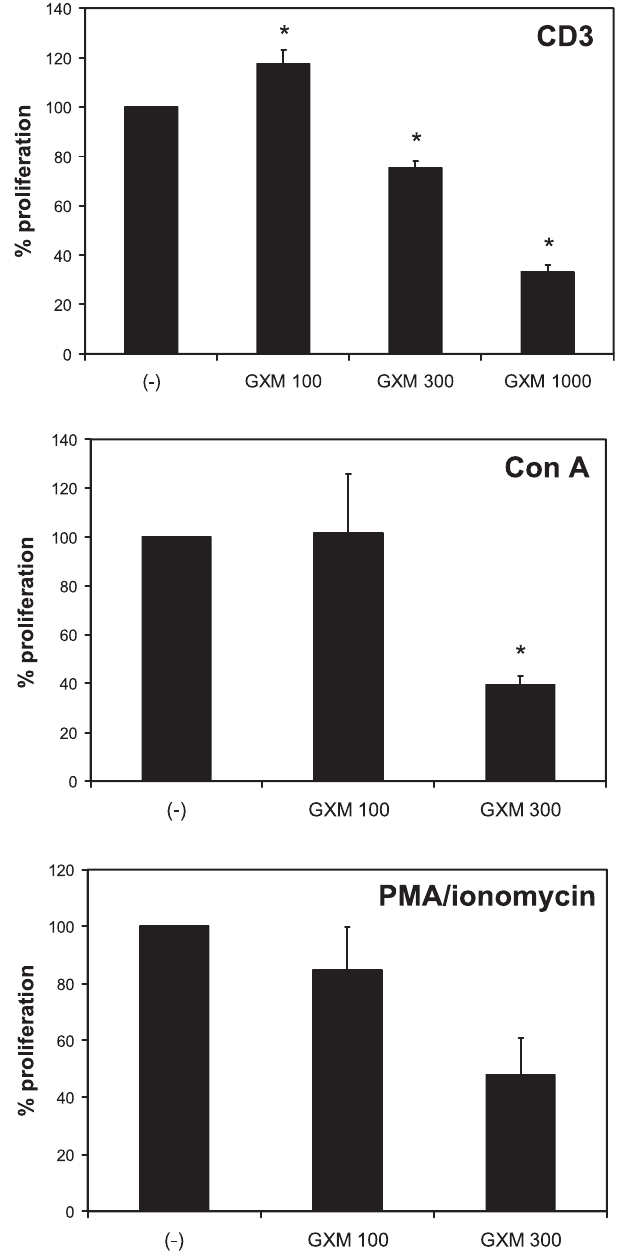
Figure 4. Effect of GXM on T-Cell Proliferation Induced by Anti-CD3, Con A, or PMA/Ionomycin Purified CD4 þ murine T cells were activated with plate-bound anti-CD3 e antibody, Con A, or PMA/ionomycin, in the presence or absence of GXM (100, 300, or 1,000 l g/ml). The data are expressed as the percent proliferation compared with the stimuli alone ( (cid:1) ) (set at 100%) 6 SEM of two to five independent experiments done in triplicate. The mean CPM for anti-CD3, Con A, and PMA/ionomycin were 224,440, 41,820, and 118,875, respectively. * p , 0.01.